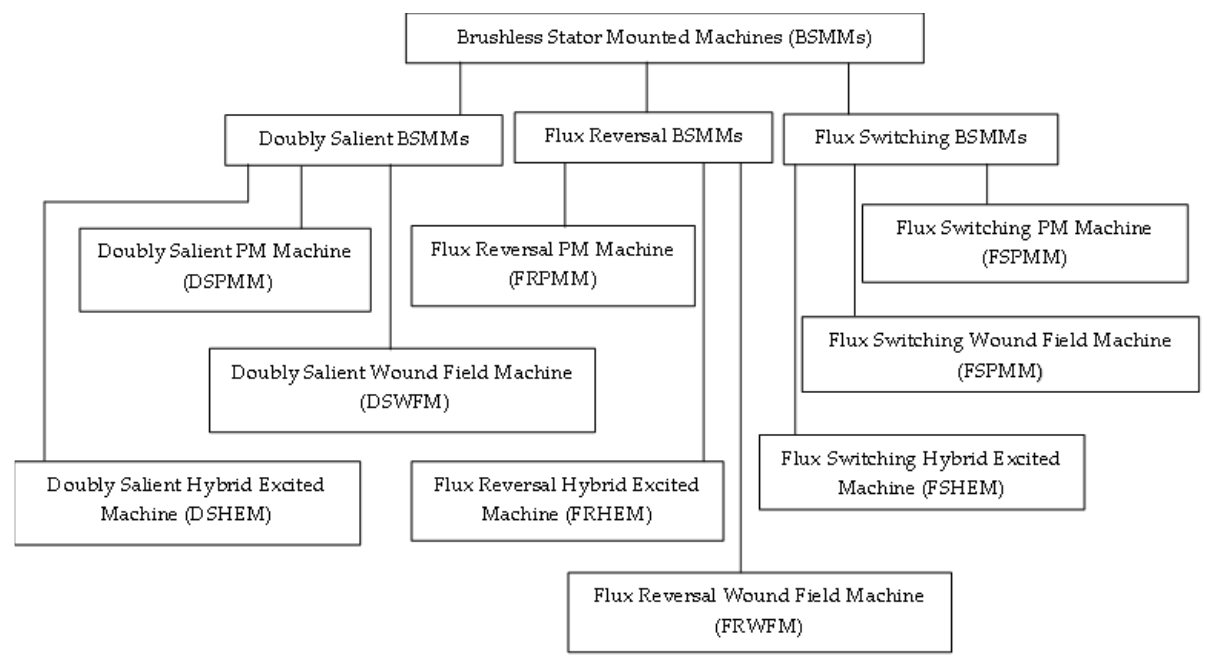
Figure 2. Classification of brushless stator mounted machines.